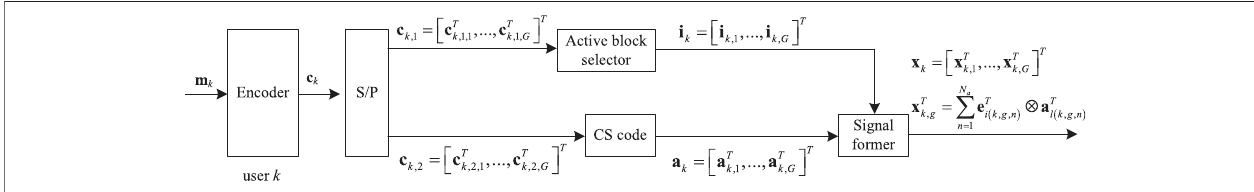
FIGURE 3 | Transmission of common information by the proposed IM-aided URA.